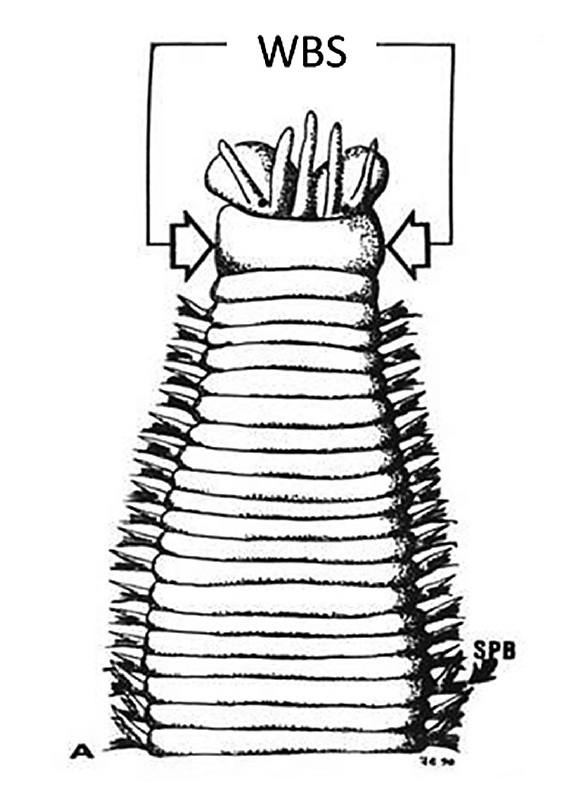
Fig. 2. – Dorsal view of the anterior region of Marphysa. sp., adapted from Garcês and Pereira (2010). B WBS = Width of buccal